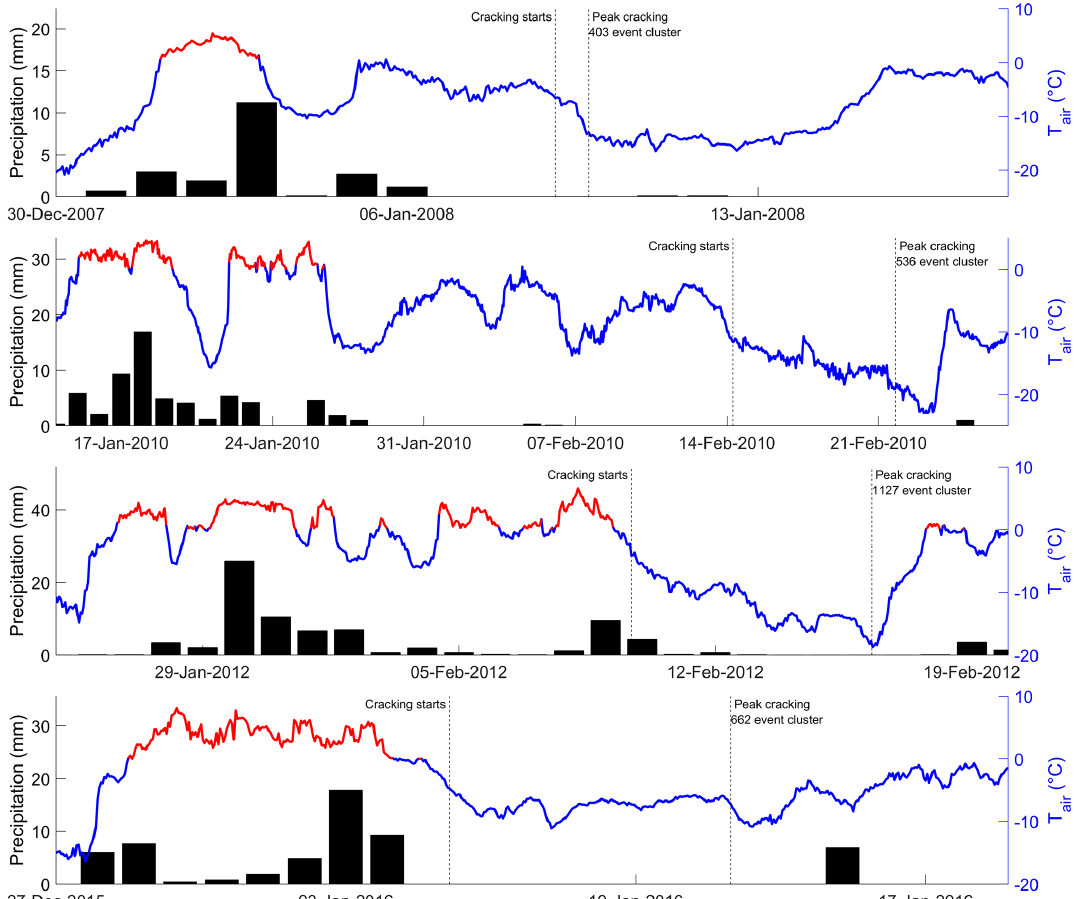
Figure B1. Svalbard Airport air temperature (line) and daily precipitation (bar) records (http://met.no, 14 January 2022) illustrate that anomalous spikes in cracking-related seismicity were preceded by unseasonably mild temperatures > 0 ◦ C (red line) and rain, presumably leading to snowmelt, water pooling, and surface ice formation as observed in the field at Adventdalen by Matsuoka et al. (2018) in February